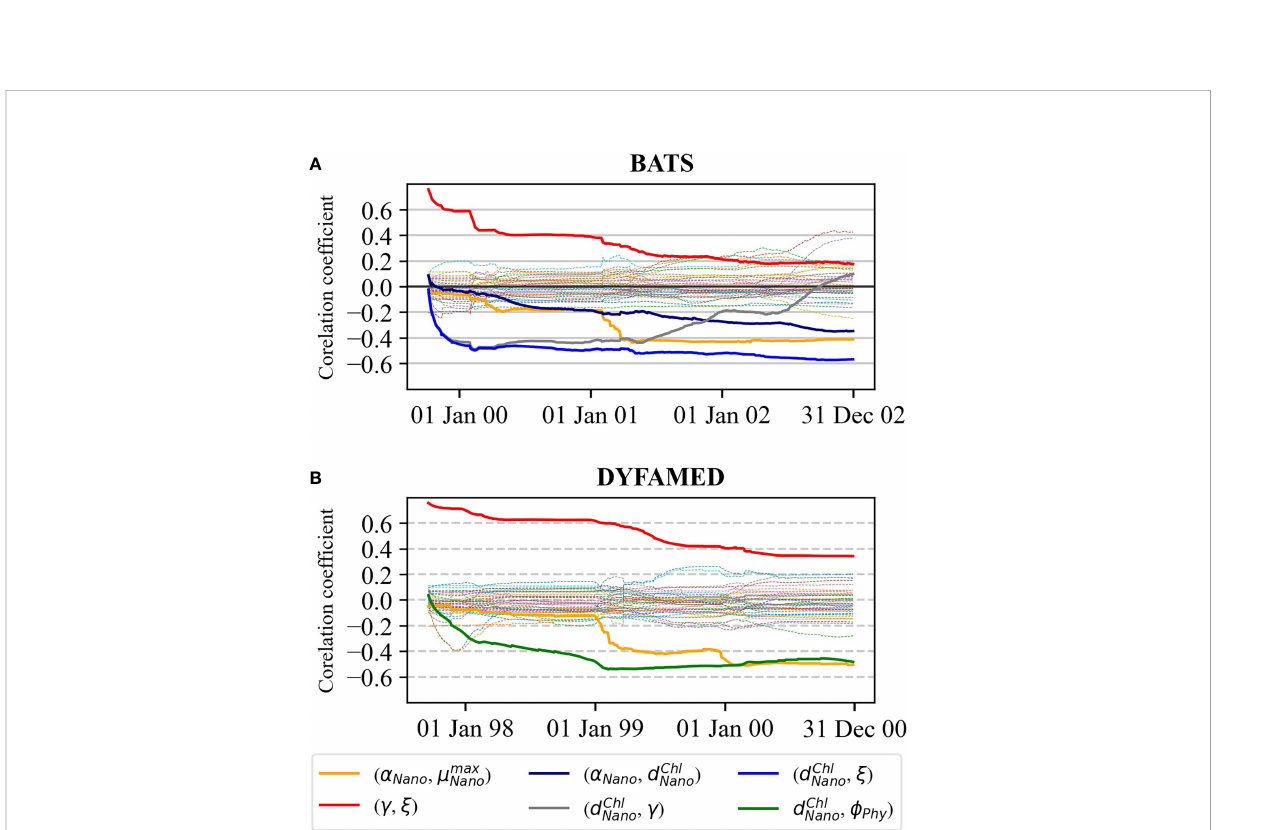
FIGURE 8 The Pearson correlation coef fi cients between each pair of the 10 biogeochemical parameters at (A) BATS and (B) DYFAMED. The solid lines denote signi fi cantly correlated